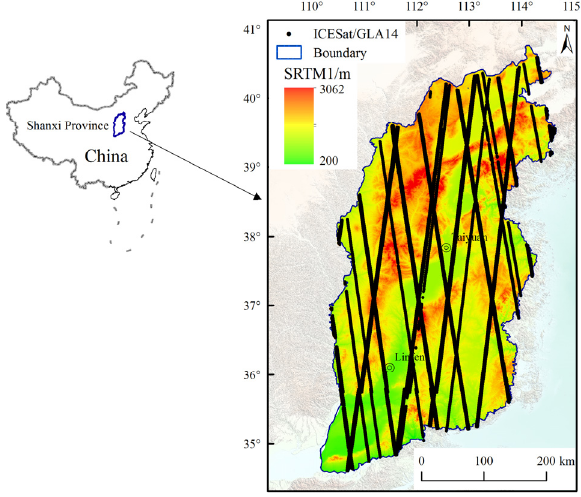
Figure 1. Study area and data